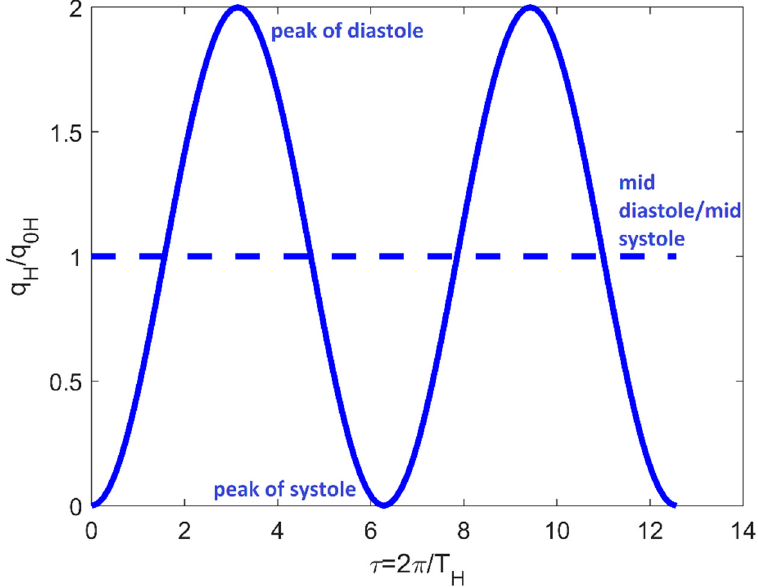
Figure 2. Time-dependent boundary condition in system (8). Full line is referred to the periodic inflow rate; dotted line indicates the mid-diastole/mid systole value.